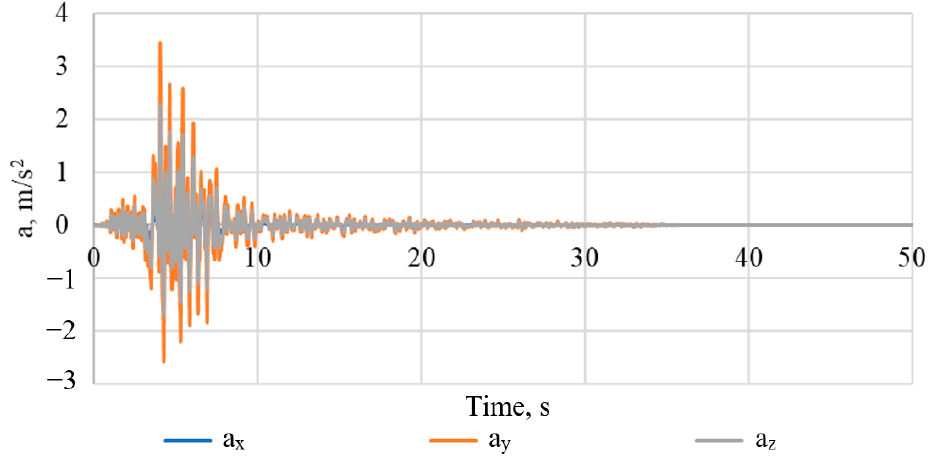
Figure 12. Calculated accelerogram of seismic impact.